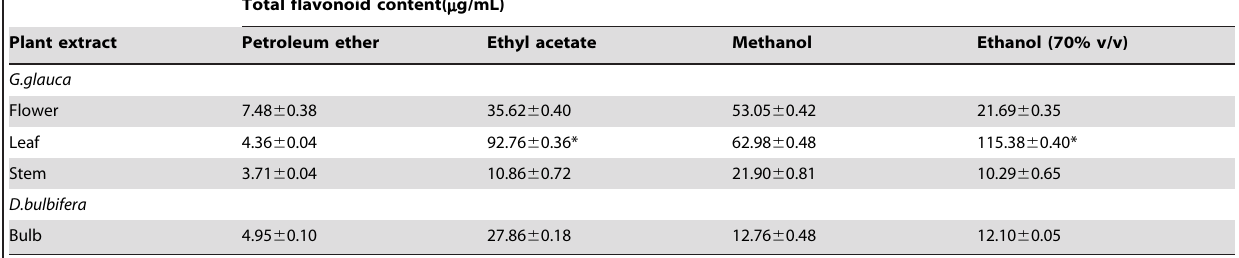
Total flavonoid content( m g/mL)